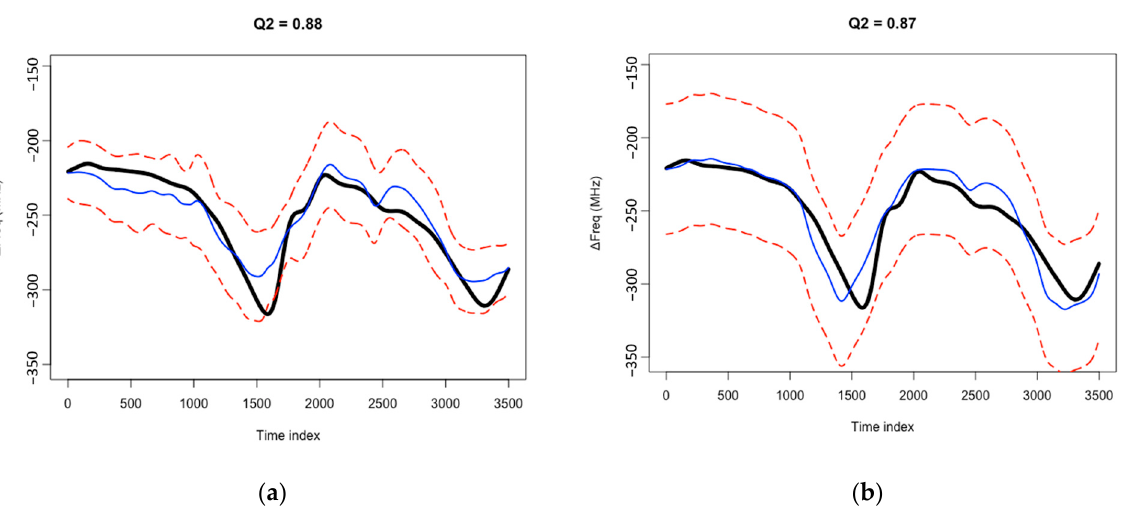
Figure 12. Prediction of output Δ Freq using a calibration model accounting either for all the environment variables ( a ) or for RH only ( b ). Q 2 is the coefficient of determination over the prediction phase. The thick black line is the sensor output, the thin blue solid line is the mean prediction of the sensor output using the calibration model learnt over the training phase and the red dotted lines are the upper and lower bounds of the 95% prediction intervals.